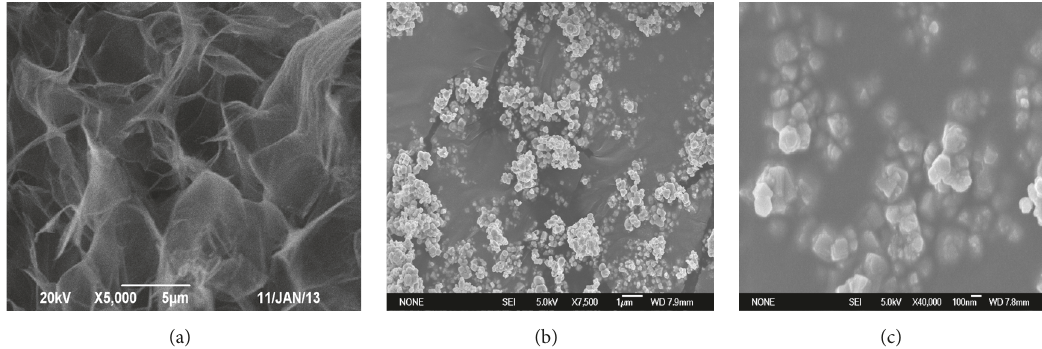
Figure 2: (a) SEM images of GO; (b) and (c) SEM images of Fe 3 O 4 / GO at different magnification.